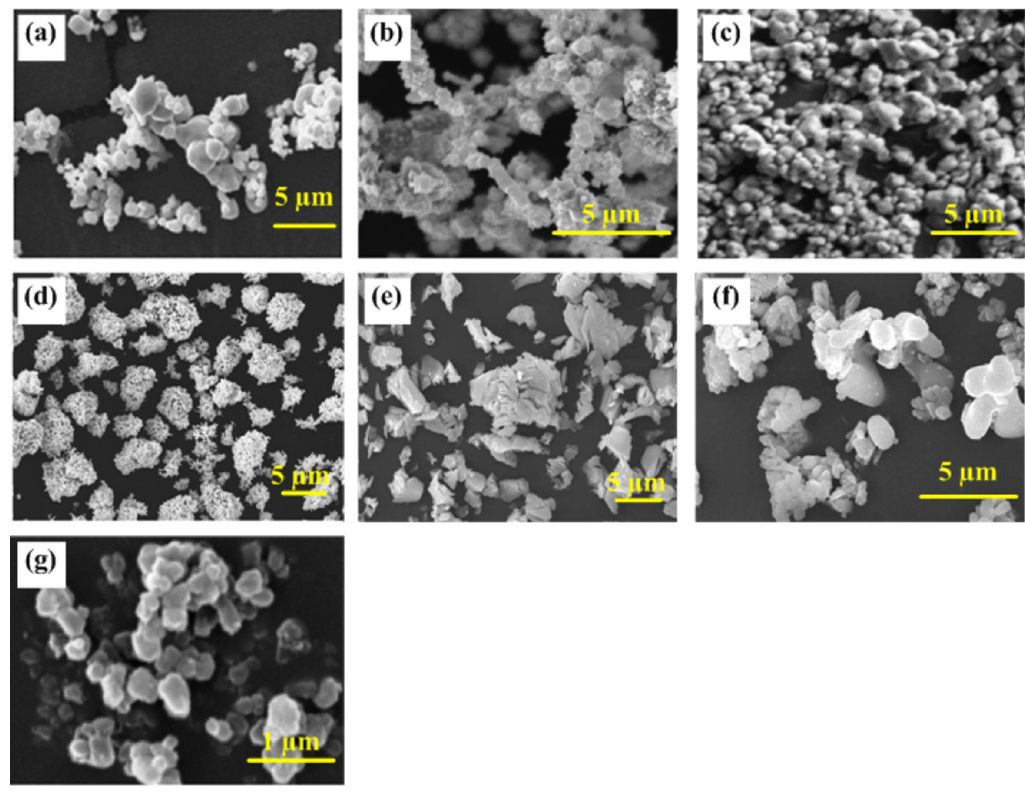
Figure 1. SEM images of the as received metals and rare metal oxide powders, where: ( a ) W, ( b ) Ni,